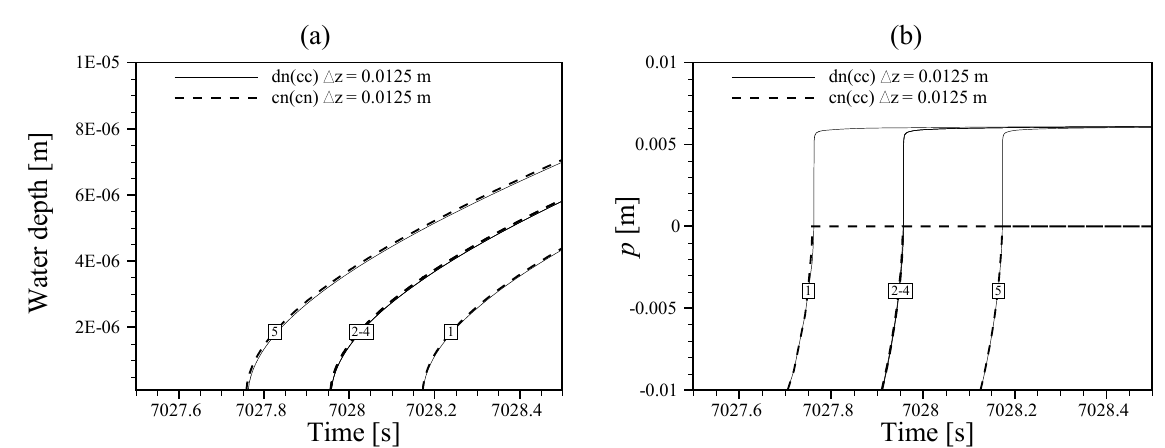
Figure 4. Simulated values at the common nodes for excess saturation on a hillslope (first scenario) with a cell-centered scheme and (cid:49)z = 0.0125m. (a) Water depths. (b) Pressure heads. Nodes are numbered 1–5 in the downslope direction.